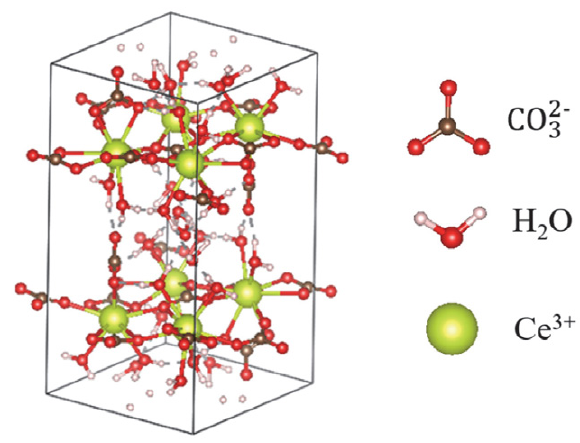
Figure 2. Ce 2 (CO 3 ) 3 crystal structure diagram, in which the green ball represents the Ce element, and each Ce element is surrounded by 4 carbonate ions and 4 water